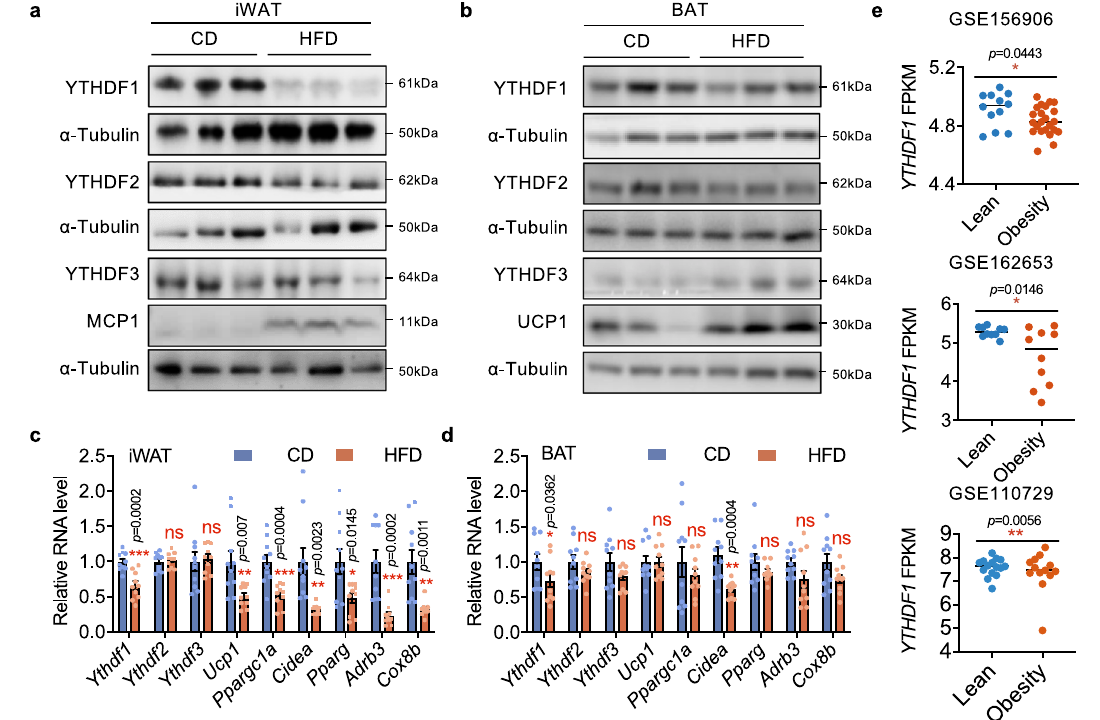
Fig. 1 | Adipose YTHDF1 expression is reduced in obesity. a , b Immunoblot analysisofYTHfamilyproteinsiniWAT a andBAT b ofmicefedwithCDorHFDfor 12weeks. c,d mRNAlevelsof Yth familygenesand thermogenesis-relatedgenesin iWAT c and BAT d of CD- and HFD-fed mice. Data were presented as mean±SEM